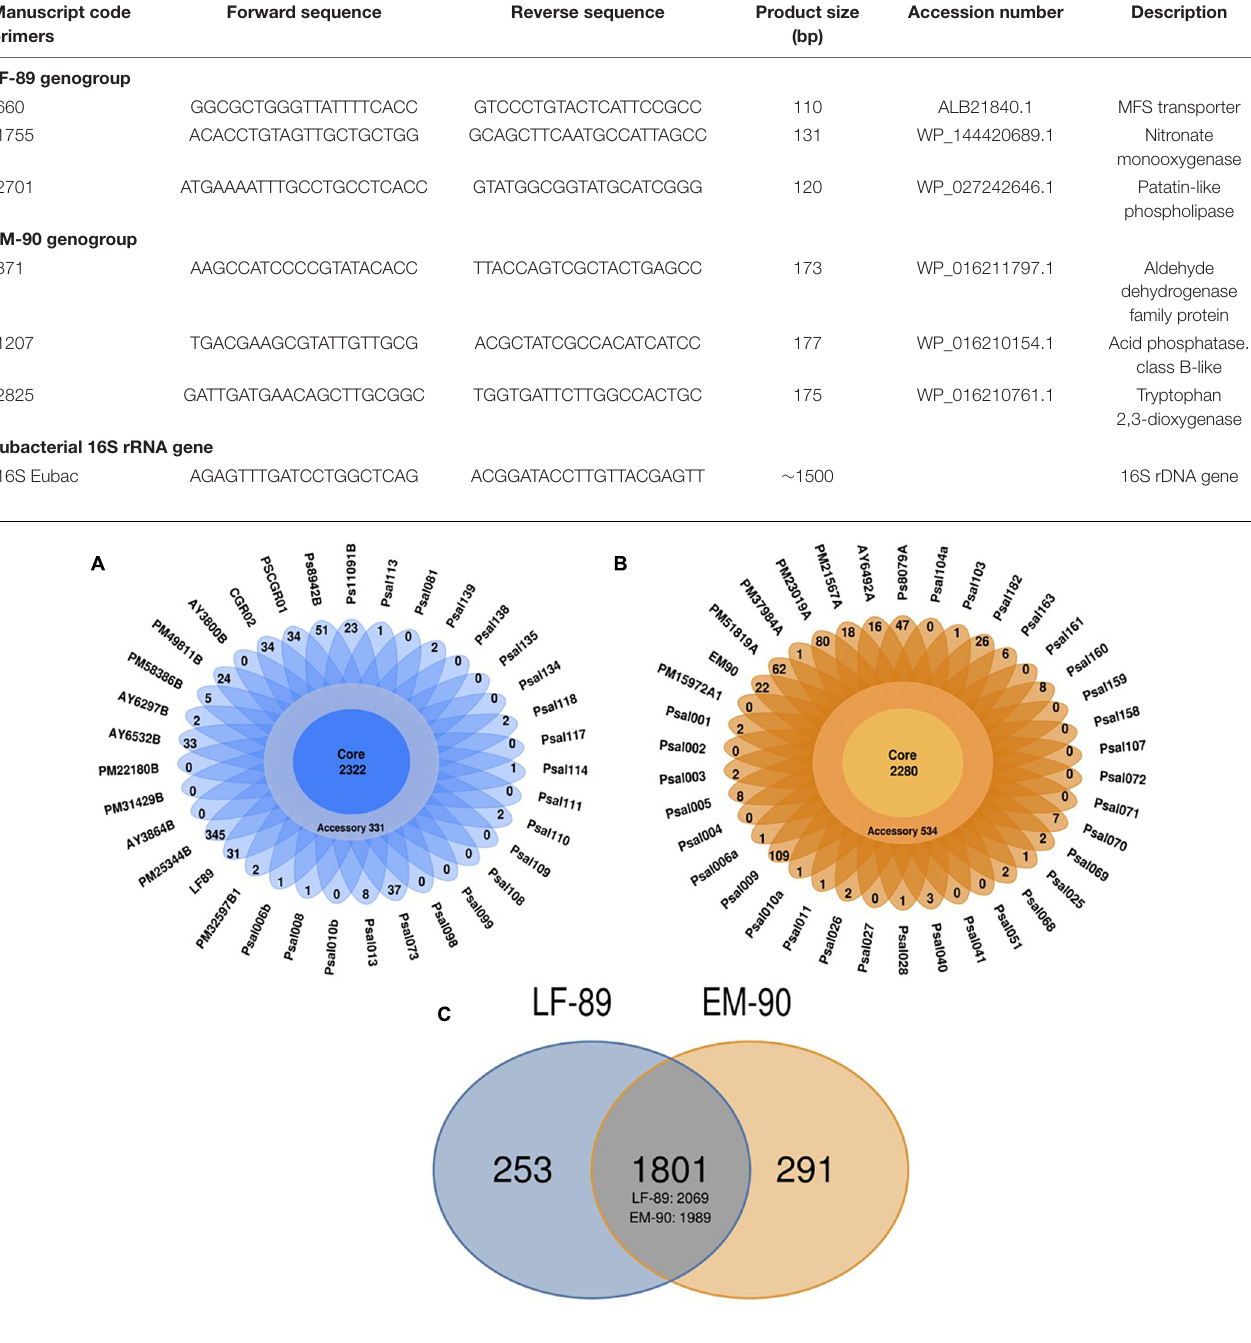
FIGURE 1 | In silico identification of core-genome in 73 genomes of P. salmonis . (A, B) Core and Accessory genes in LF-89 and EM-90 genomes, respectively. (C) Ven-diagram of unique and shared sequences between LF-89 and EM-90 genomes. The intersection corresponds to shared gene clusters, and the numbers under the intersection correspond to the total number of genes